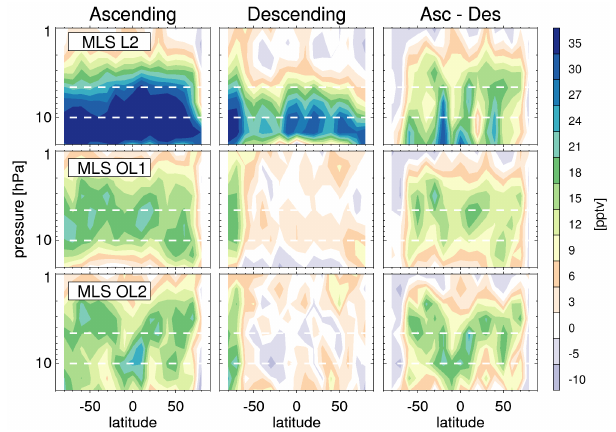
Fig. 3. Averaging kernels for the retrieval of BrO mixing ratio at the equator (those at other latitudes are very similar). The black line is the integrated area under each kernel: values near unity indi- cate that most information was provided by the measurements while lower values indicate that the retrieval was influenced by the a pri- ori. The dashed gray line is a measure of the vertical resolution of the retrieved profile (derived from the full width at half maximum (FWHM) of the averaging kernels approximately scaled into kilo-